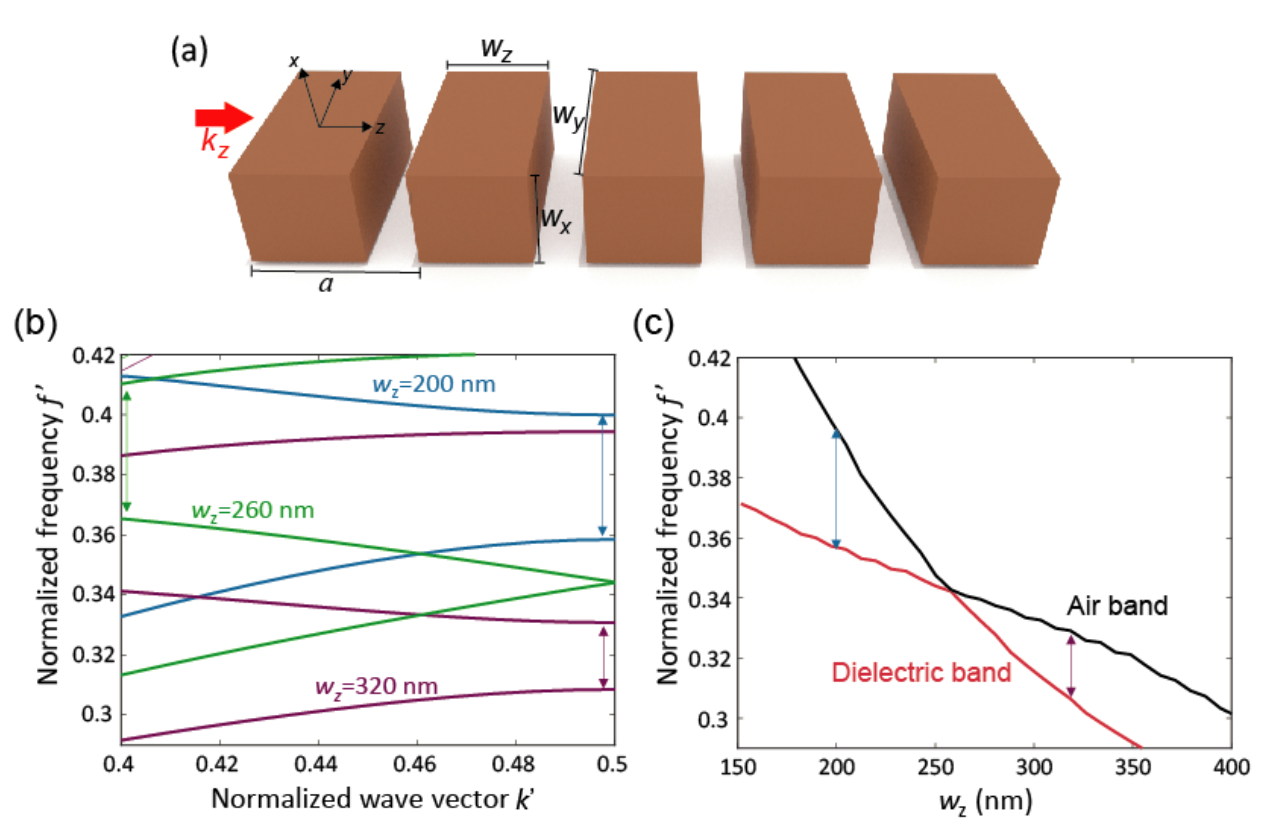
Figure 1. ( a ) Sketch of the 1D periodic systems under study: a chain of high-index dielectric nanobricks. ( b ) Photonic bands for x -even parity (TE-like) modes for different values of w z . ( c ) Frequencies of the dielectric and air bands as a function of w z . Vertical arrows show the PBG for each value of w z (for w z = 260 nm a higher-order PBG is shown). The numerical simulations were performed for a 1D periodic chain of nanobricks with index n = 3.5 and dimensions w x = 220 nm, w y = 450 nm, a = 455 nm. The normalized frequency f’ is given in units of ω a/2 π c , ω being the angular frequency and c the speed of light in vacuum. The normalized wave vector k’ is given in units of 2 π k/a.